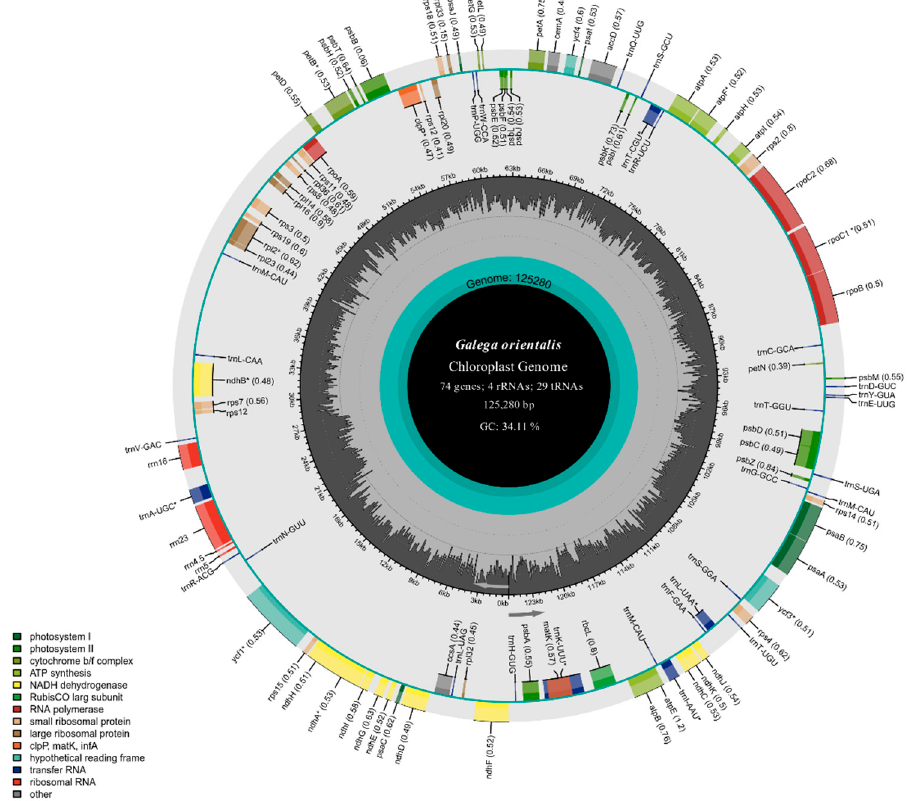
Figure 1. The chloroplast genome map of Galega orientalis . The genes drawn inside and outside of the circle are transcribed counterclockwise and clockwise, respectively. The dark gray inside the circle represents GC content, and the light gray corresponds to AT content. * Genes with introns.